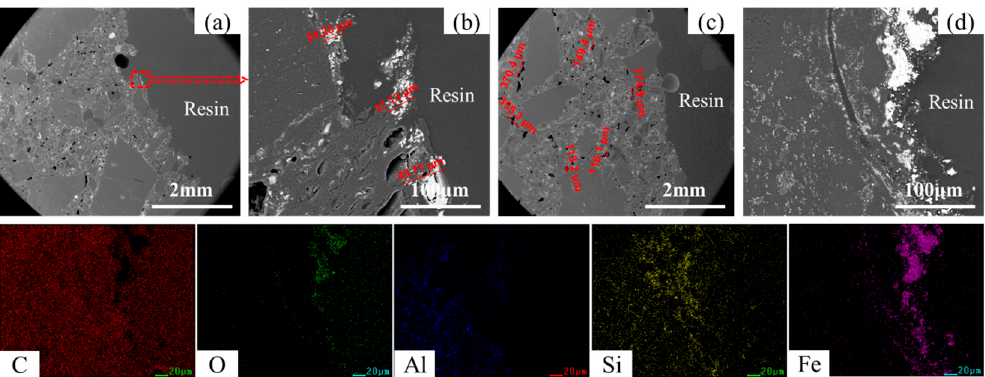
Figure 12. ( a – d ) Microscopic morphology of B after corrosion.